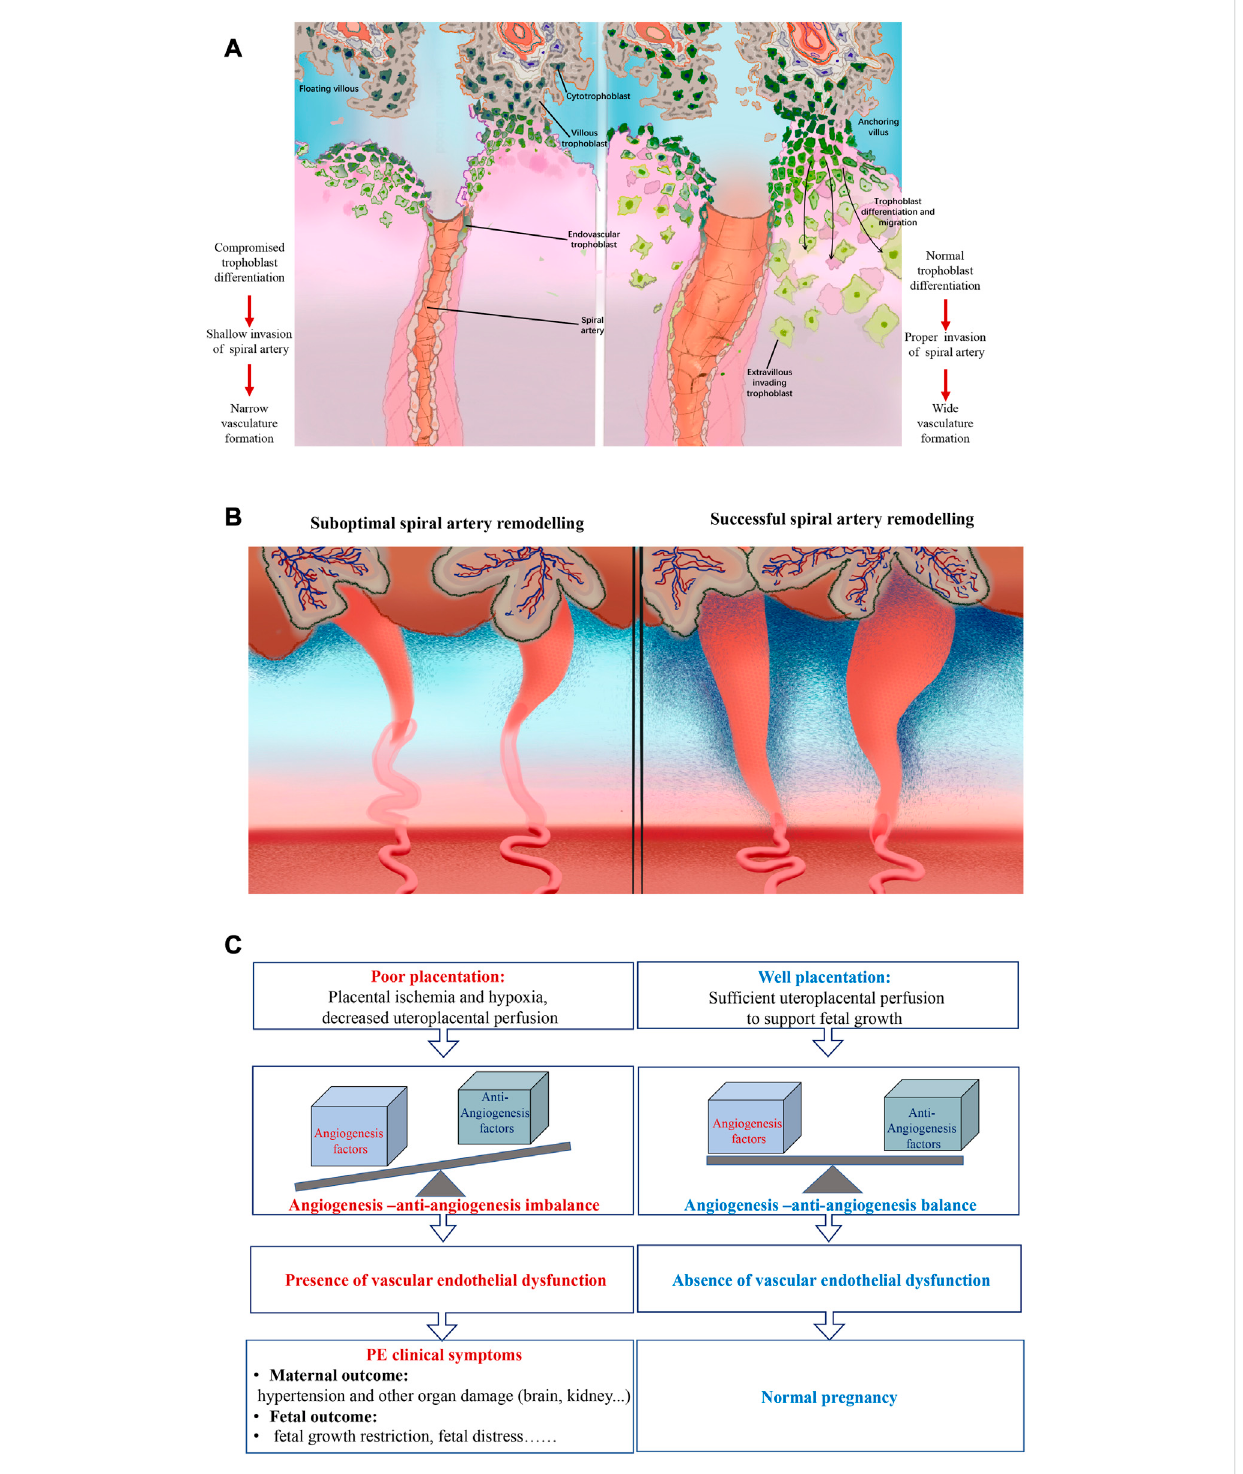
FIGURE 2 SchematicoverviewofthepathologyofPE(left)andnormalphysiologyofpregnancy(right) (A) Diagramoftrophoblastinvasionatthefetal-maternal interface. Under the PE condition, ferroptosis potentially mediated compromised cytotrophoblast cell differentiation leads to the shallow invasion of spiral artery remodeling and further narrow vasculature formation. Whereas in normal pregnancy, the physiological and normal differentiation of trophoblast contributes to the proper spiral artery construction and wide vasculature architecture. (B) Schematic representation of the model of spiral artery remodeling of PE condition and normal pregnancy. Compared with normal and physiological pregnancy, the spiral artery remodeling is less suf fi cient and adequate under PE conditions as the result of narrow and thick-walled spiral arteries formation. (C) Diagram of the suboptimal remodeling resulted PE pathophysiology and physiology of normal pregnancy. Compared with a healthy pregnancy, PE was characterized by placenta ischemia and hypoxia and decreased uteroplacental perfusion, known as poor placentation. This further leads to angiogenesis and anti-angiogenesis imbalance and consequently vascular endothelial dysfunction. Finally, the characterized PE clinical symptoms will present both in pregnant women manifested as multi-system affected damage and in neonates presented as adverse birth